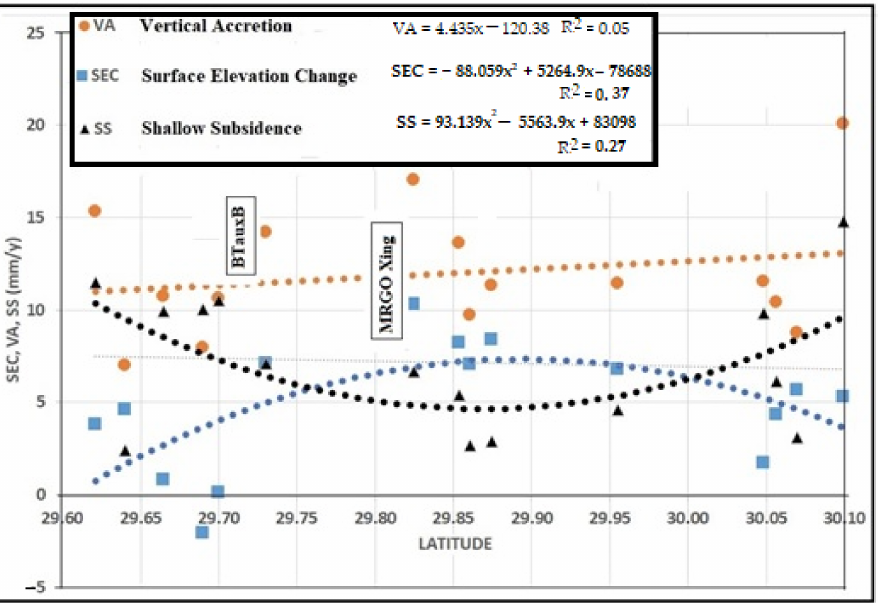
Figure 12. Spatial distribution with Latitude of decadal mean rates (2008–2018) of Vertical Accretion (VA), Surface Elevation Change (SEC) and Shallow Subsidence (SS) on the CRMS Transect (Figure 3, Table